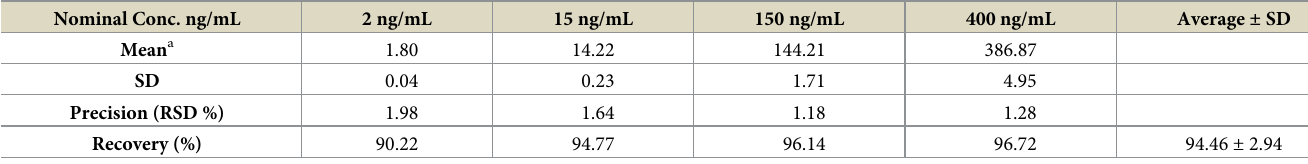
Table 3. RLMs matrix effect on the DMB analysis. Nominal Conc. ng/mL